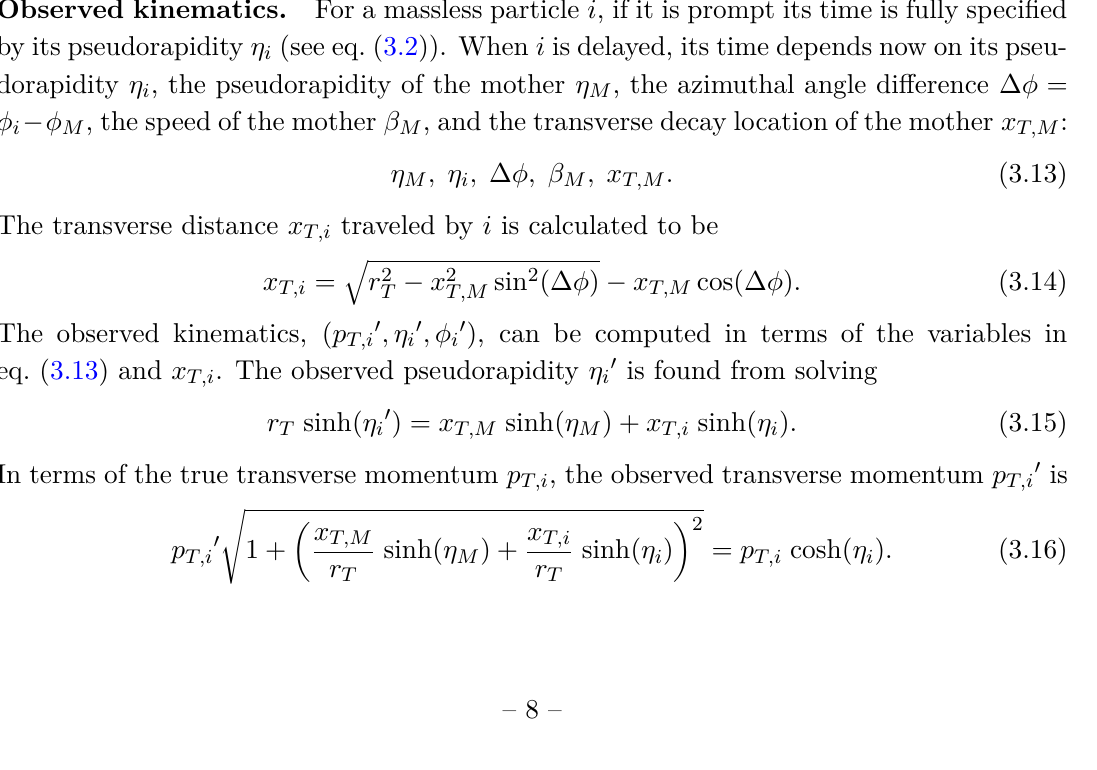
until it crosses the detector. If the displaced vertex is not i 0 i